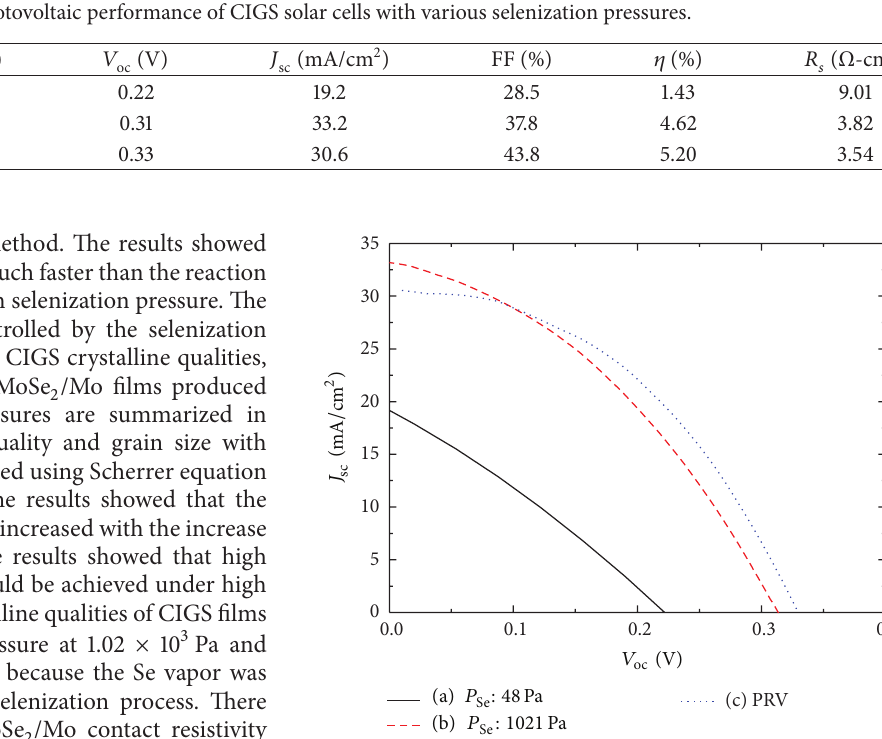
Table 1: Crystalline and electrical properties of CIGS/MoSe